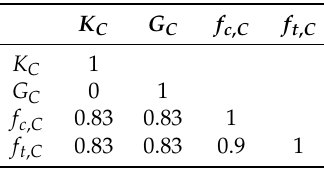
Table 3. Correlation Matrix of the concrete mechanical parameters.